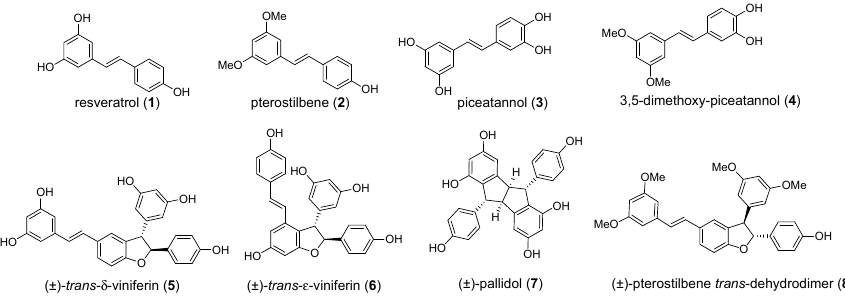
Figure 1. Structures of the representative stilbenoid monomers ( 1 – 4 ) and dimers ( 5 – 8 ).